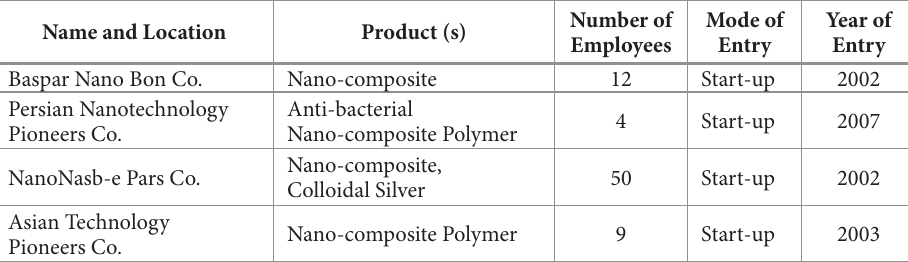
Table 1. Ten case study Iranian nano-composite companies Name and